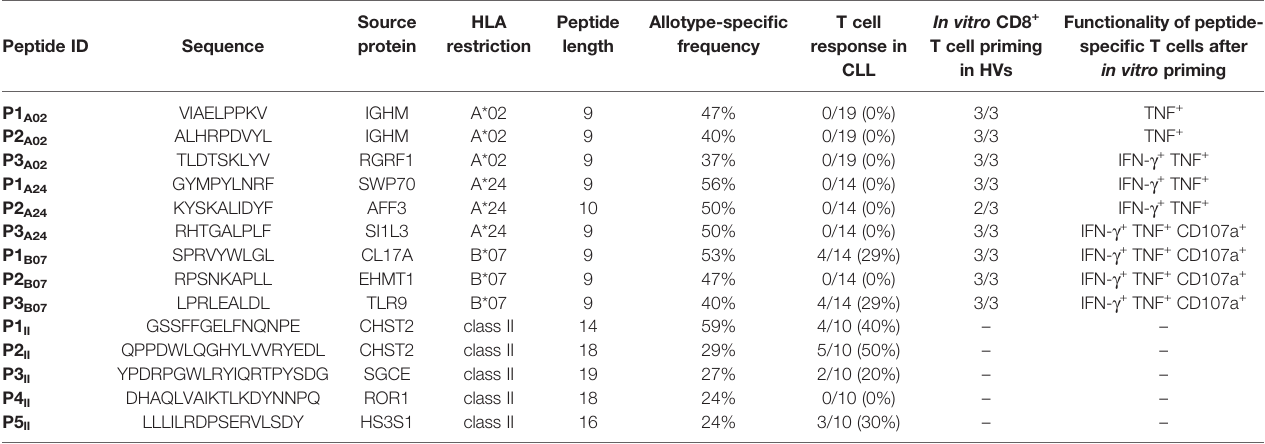
TABLE 1 | Immunogenicity of CLL-associated warehouse